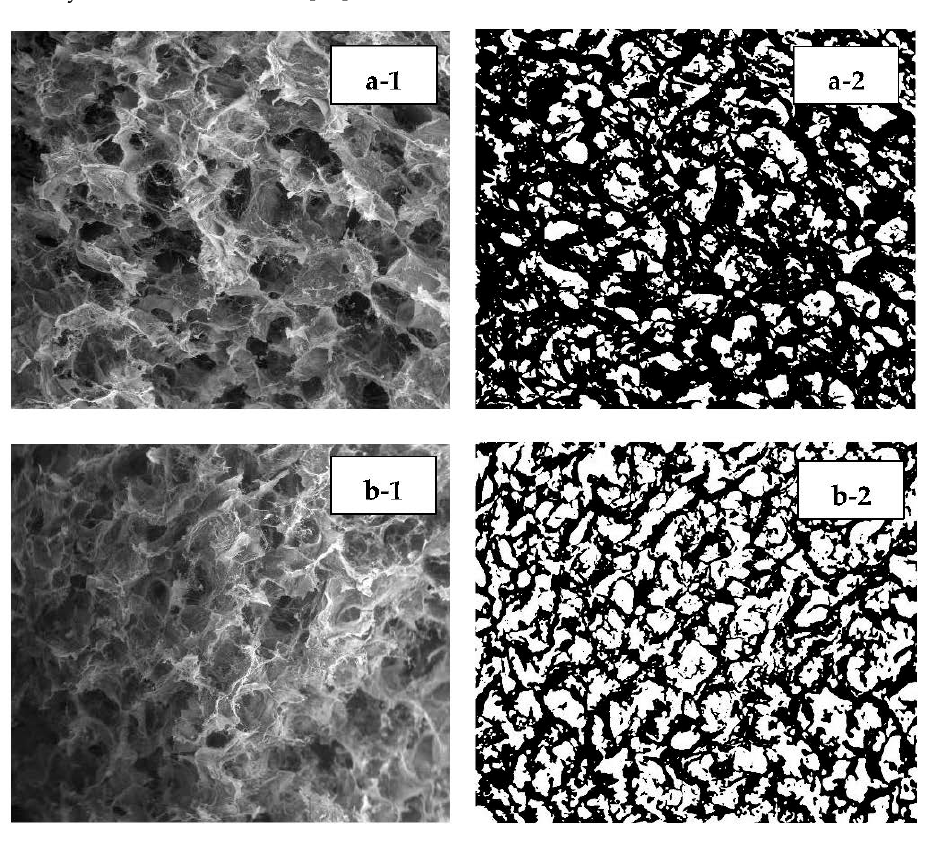
Table 2. Degradation in percentage of hydrogel composite Alginate/PVA/r-GO. Sample